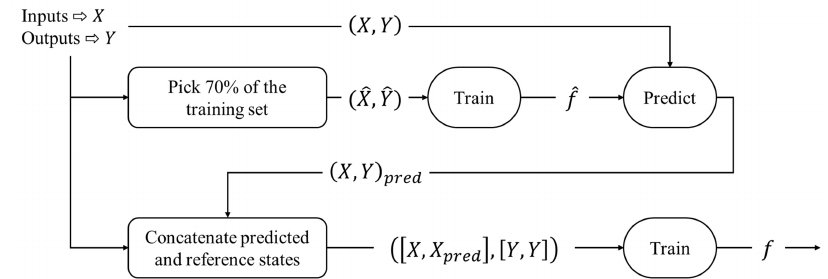
Figure 10. Learning process for the self controlled